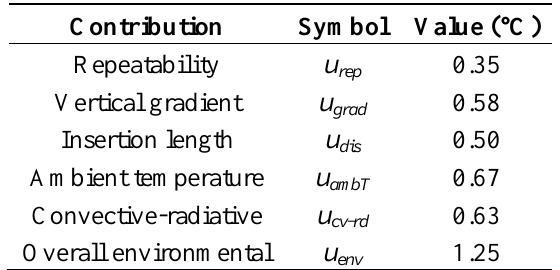
Table 3. Environmental uncertainty contributions.